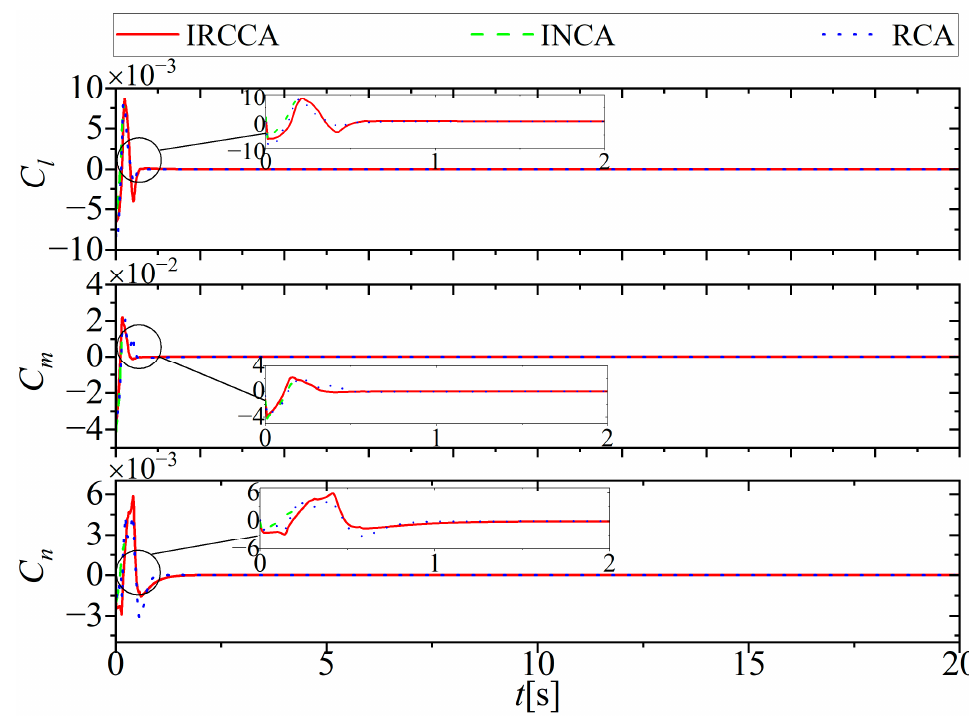
Figure 19. Time response of the moment coefficient with multiple faults.